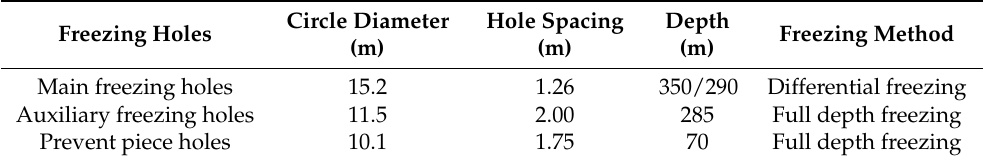
Table 2. Layout parameters of freezing